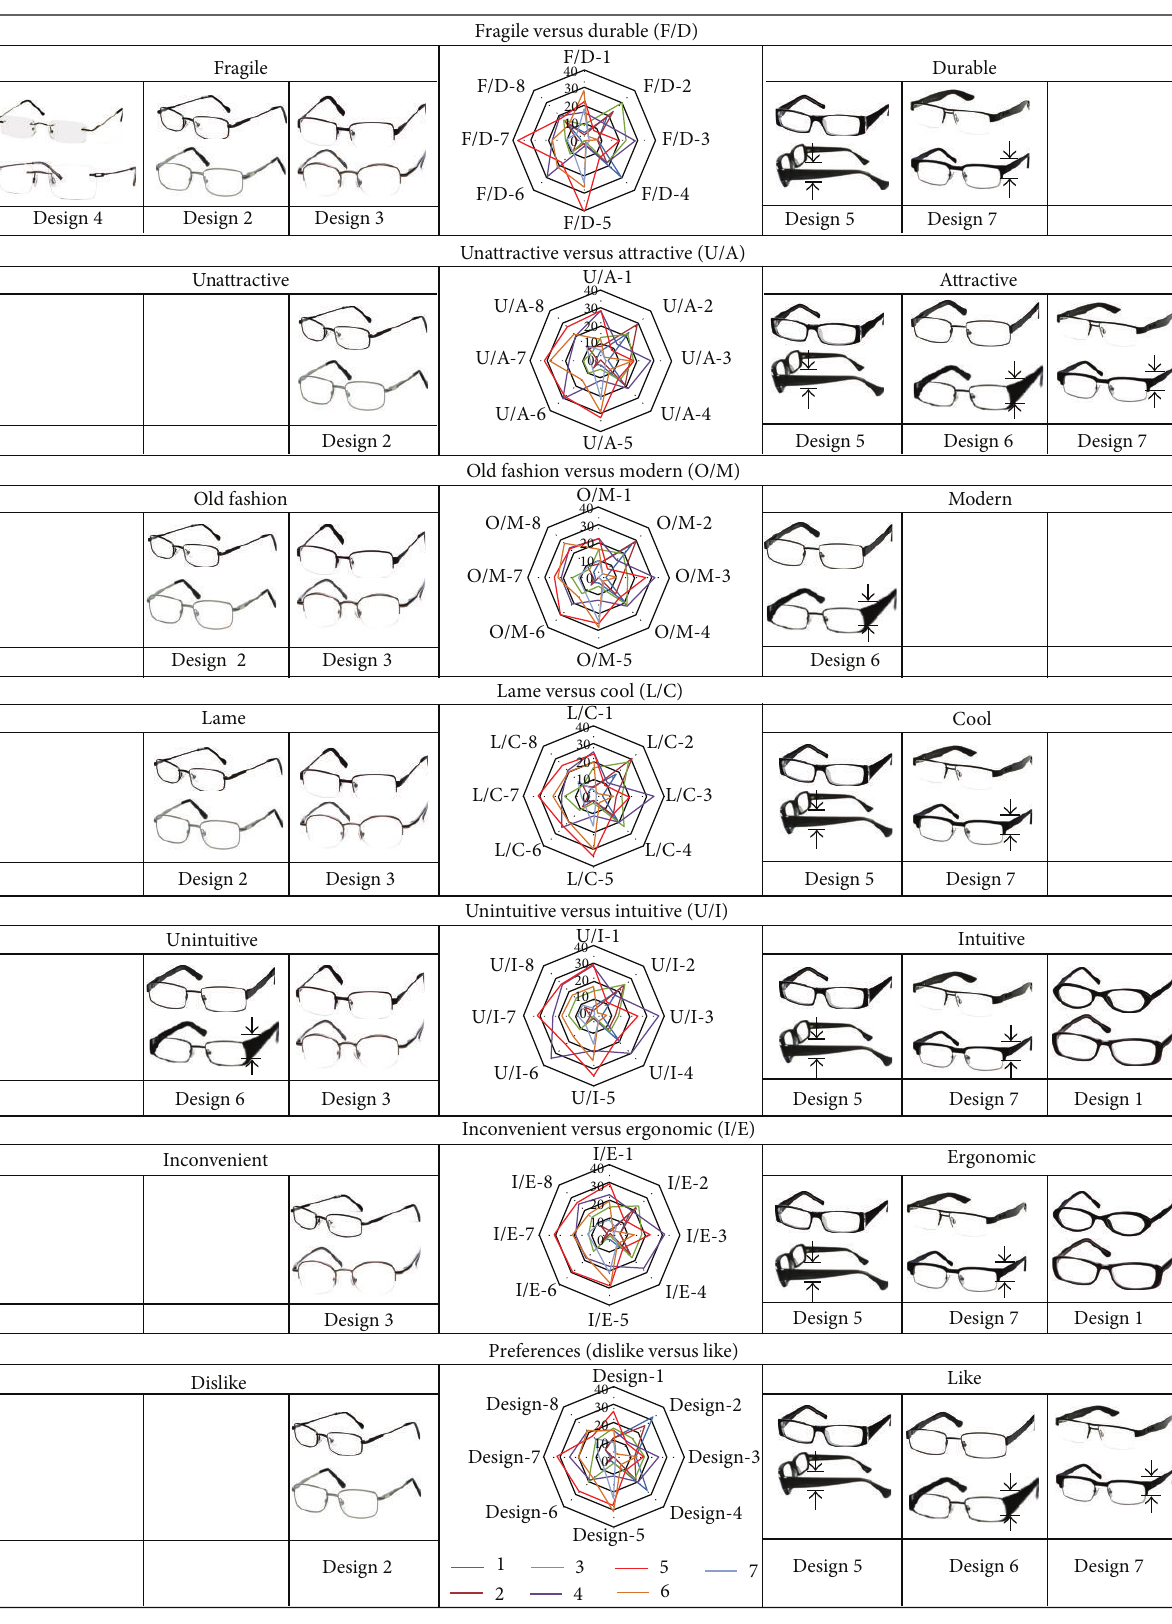
Figure 6: Location of the design preferences based on Kansei